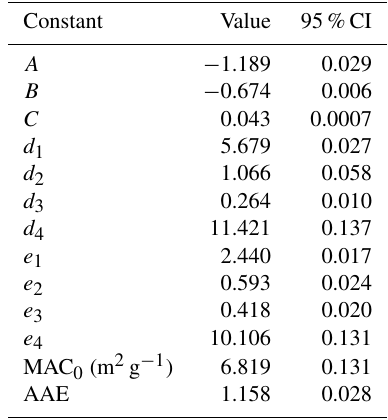
Table 1. Value of the constants used for the fitting of MAC BC